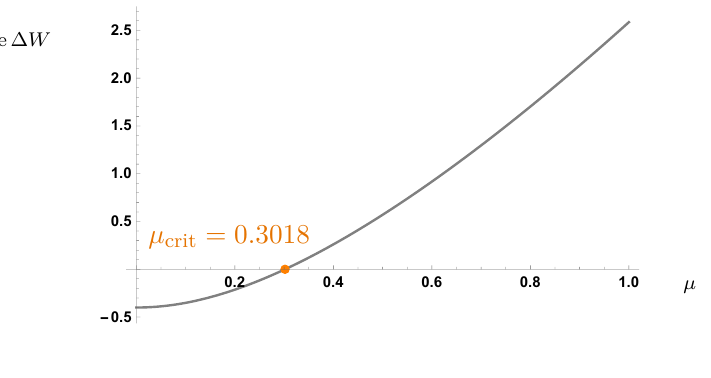
Figure 8 . Plot Re ∆ W ( µ )